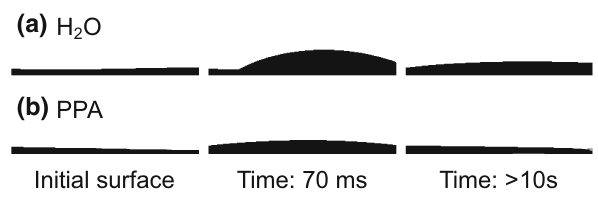
Fig. 4 Time-series of photographs illustrating the wetting behaviour